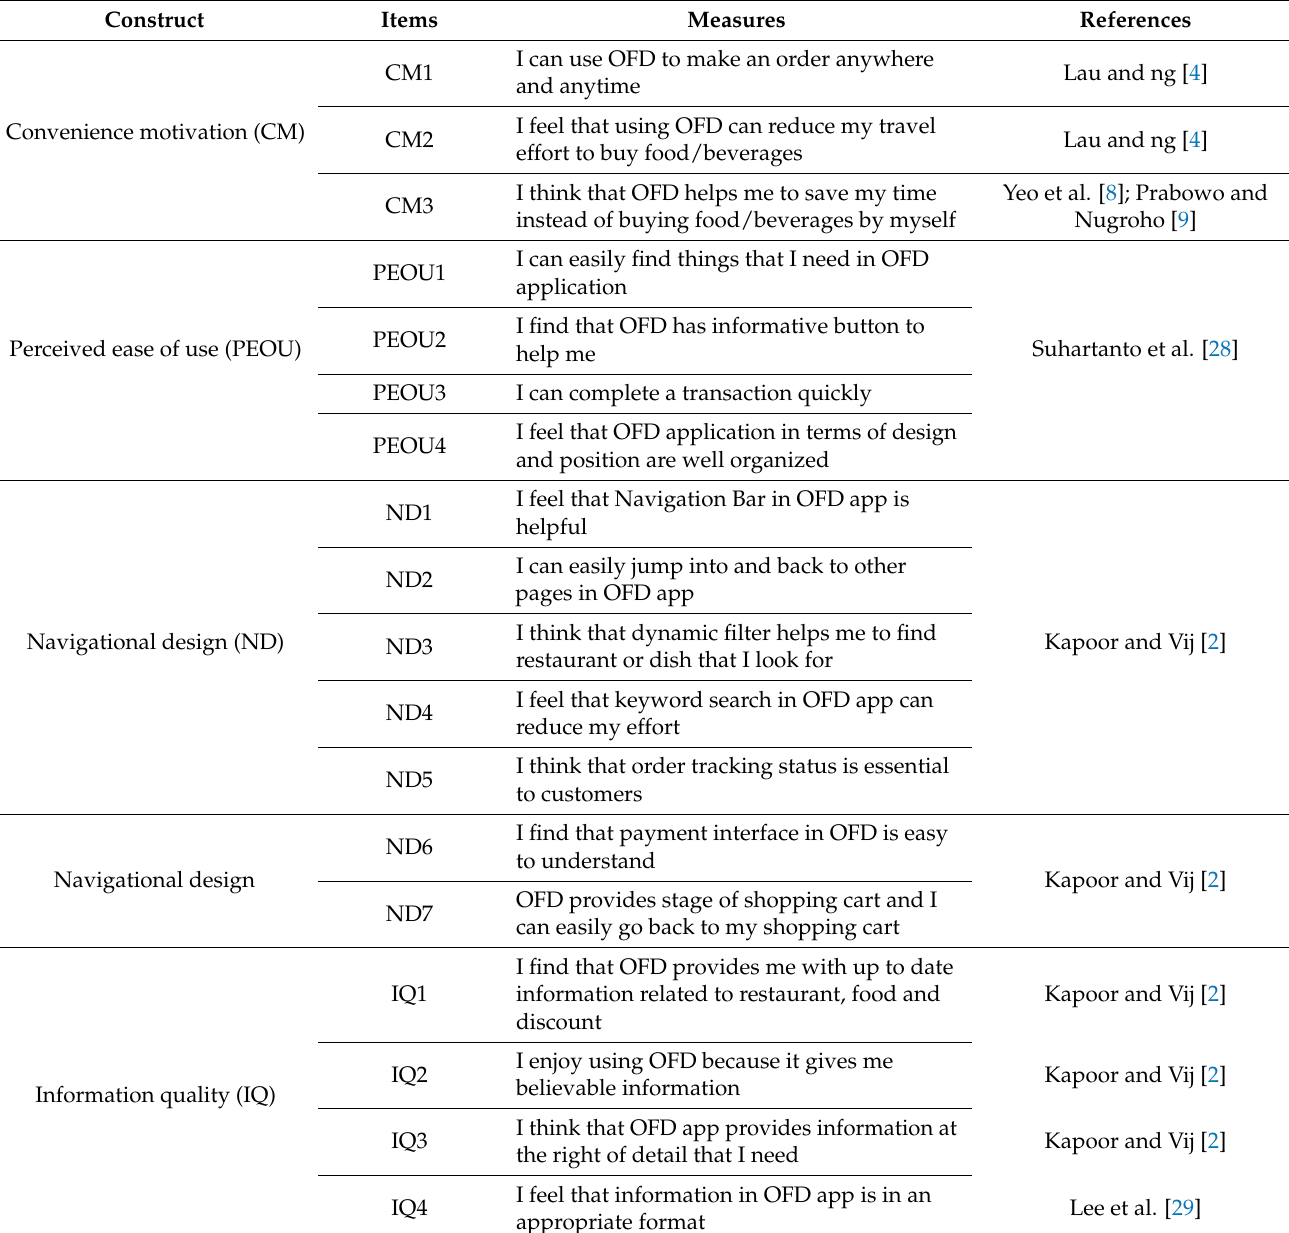
Table 2. Constructs and measurement